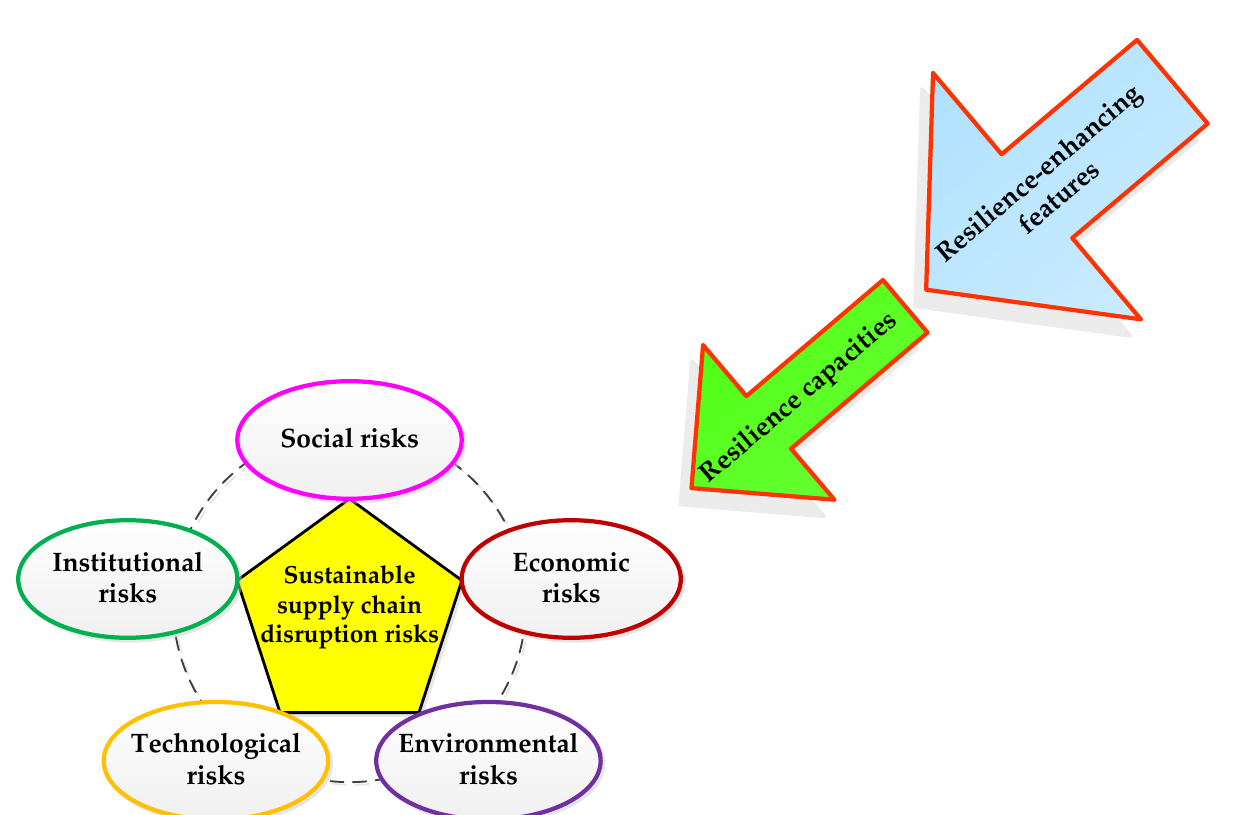
Figure 2. The resilience-enhancing strategy to mitigate risk for sustainable supply